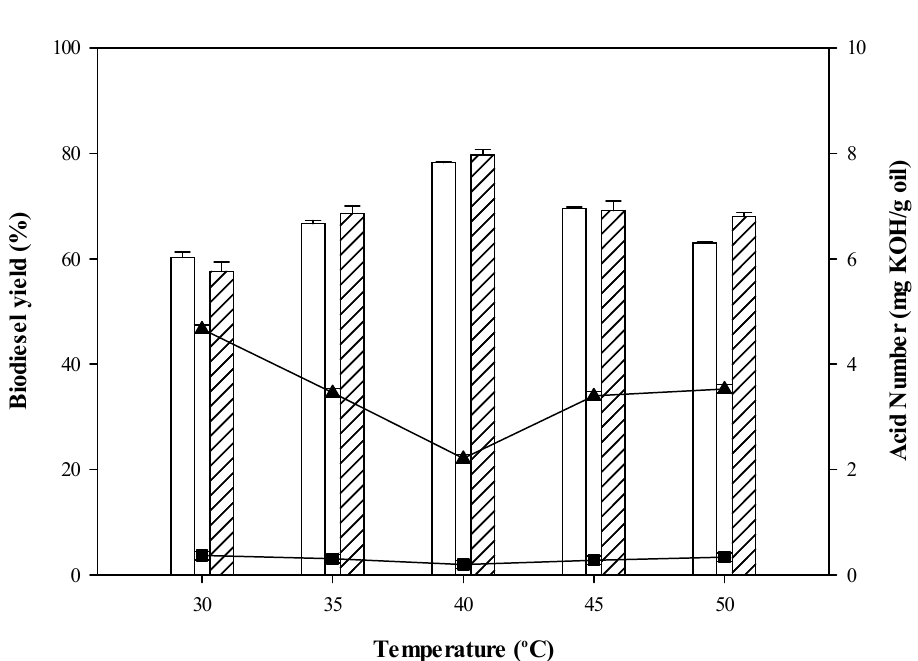
Figure 1. Biodiesel yield (%) as function of temperature (°C) and acid number (mg KOH/g oil) (CPO biodiesel yield RPO biodiesel yield ▲ CPO acid number ■ RPO acid number . biodiesel yield (cid:78) CPO acid number (cid:4) RPO acid number.